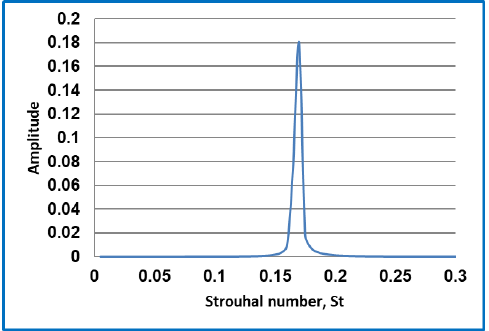
Figure 5: Strouhal number of the fixed cylinder at Re = 100